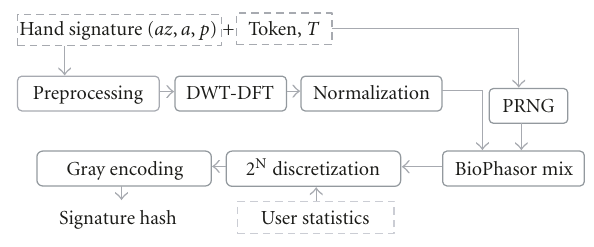
Figure 1: Outline of proposed